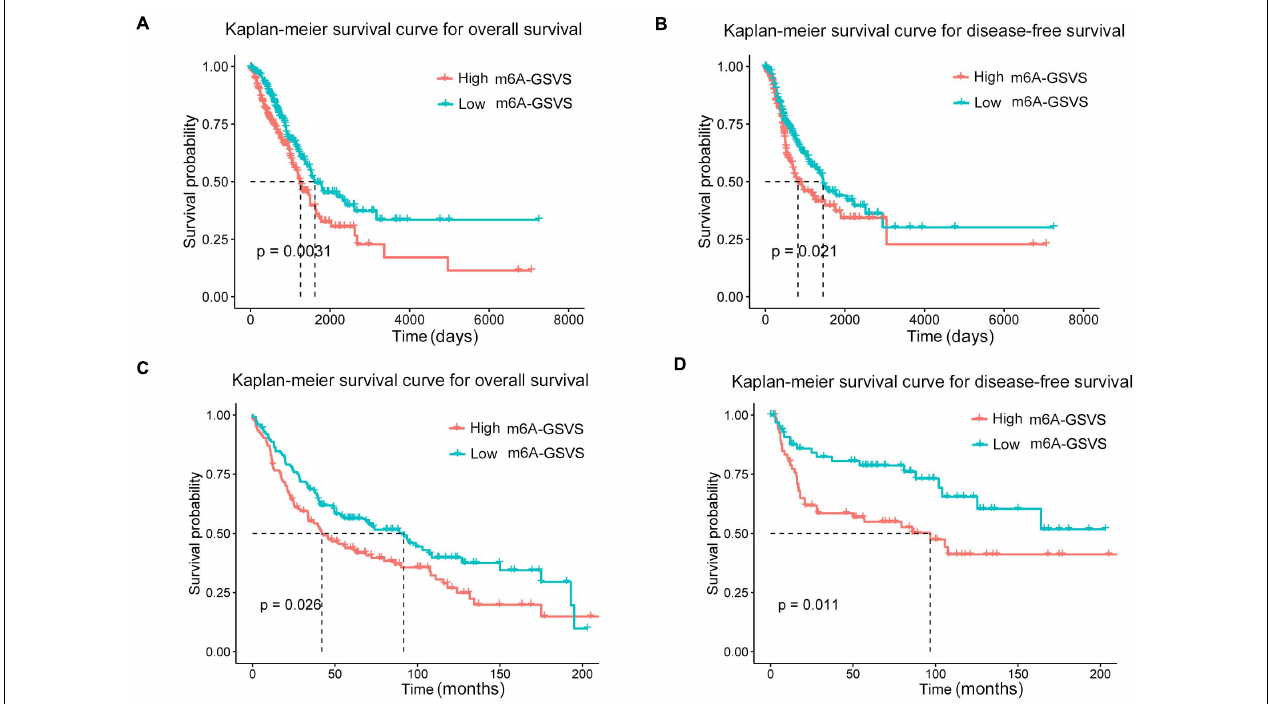
FIGURE 6 | Kaplan–Meier curves for overall survival and disease-free survival of lung adenocarcinoma patients stratified by m6A-related gene set variation score (m6A-GSVS). (A,B) Analysis of patient data in the lung adenocarcinoma dataset in The Cancer Genome Atlas. (C,D) Analysis of patient data in the GSE3141, GSE30219, and GSE37745 datasets.